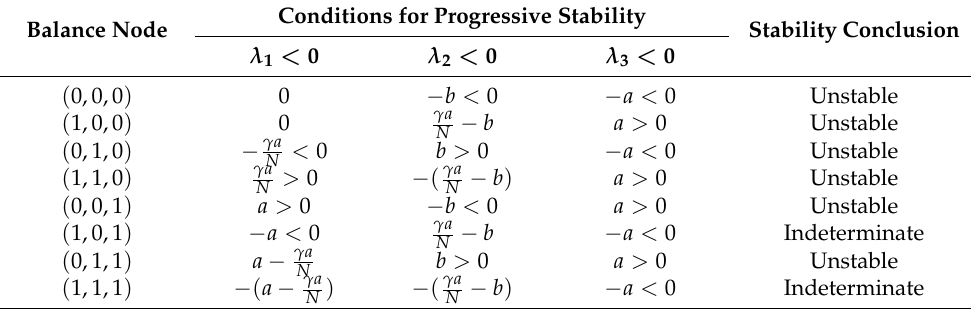
Table 5. Balance point stability analysis.